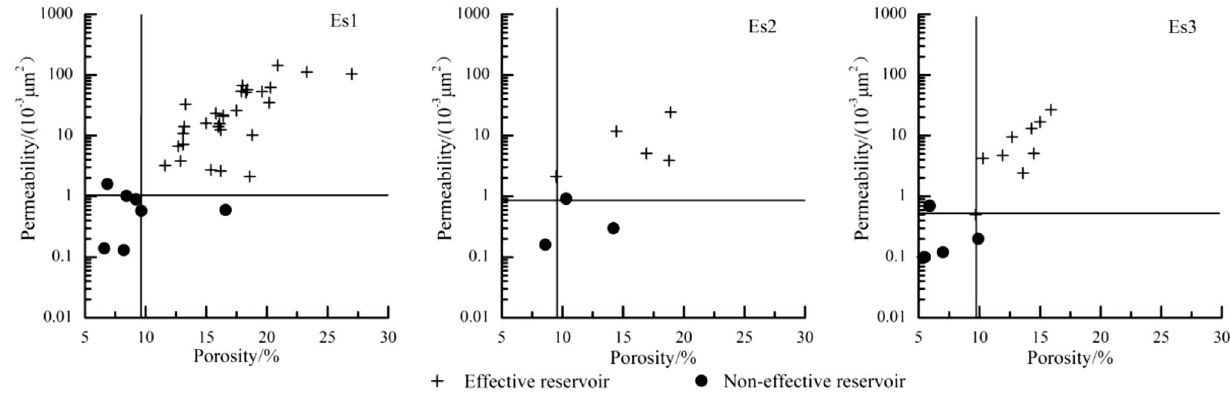
Fig. 2 Lower limit of physical properties determined by the oil test method